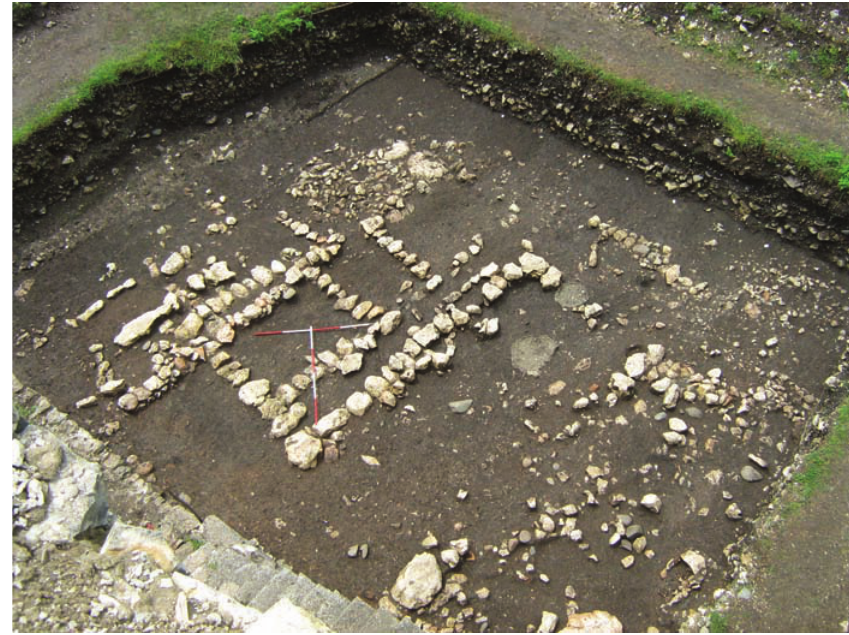
Figure 5 View of Trench A from the top of the fortification wall (looking